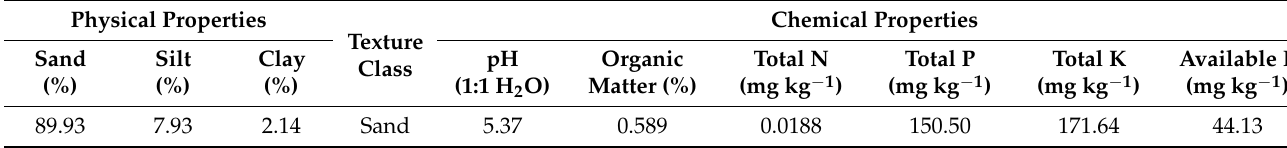
Table 1. Soil chemical characteristics and physical